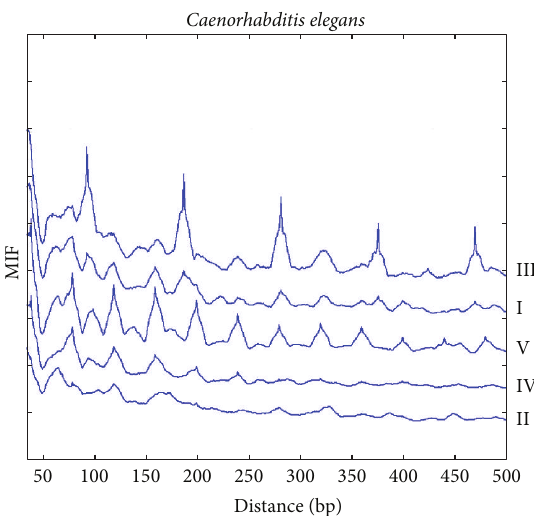
Figure 1: MIF profile of the decamer YYYYYRRRRR from a synthetic sequence. Note the 10-base periodicity. Figure 2: The MIF profiles of the decamer YYYYYRRRRR in 5 C. elegans